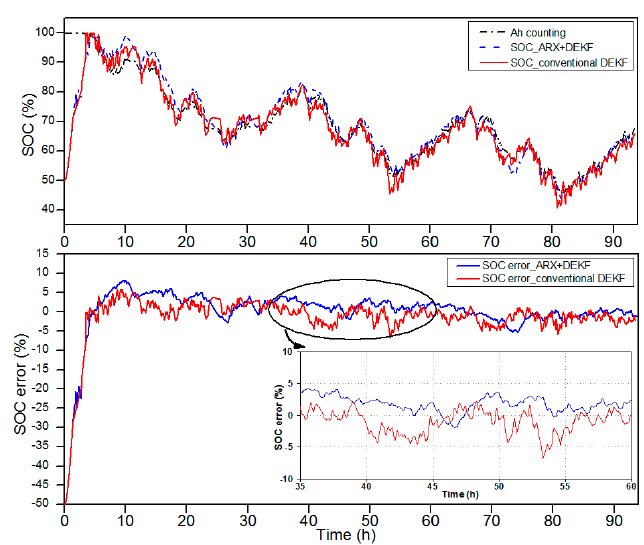
Figure 5. Comparison of the SOC estimation for the first battery (98% SOH) by the proposed ARX-DEKF and conventional DEKF method.